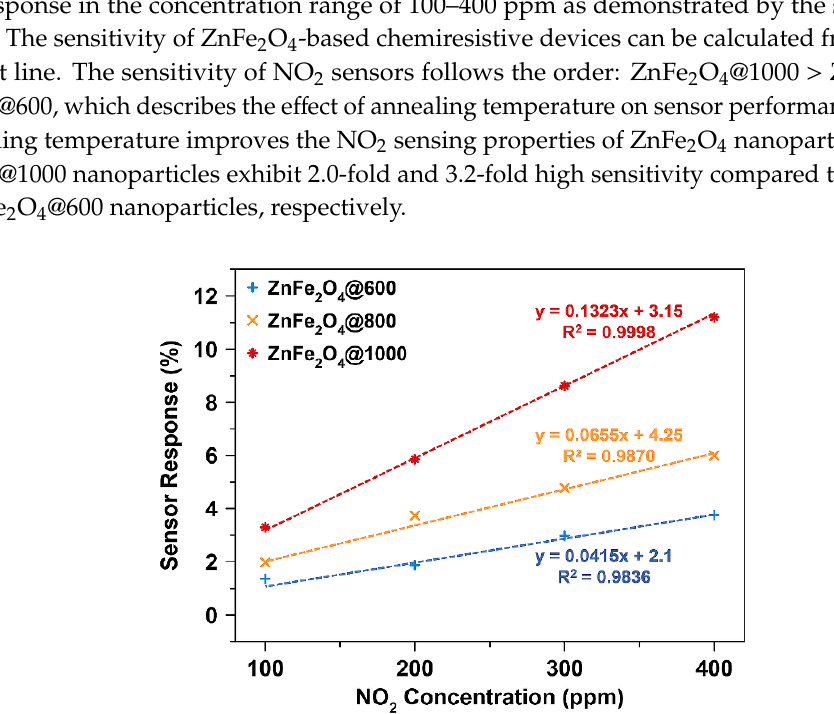
Figure 7. The calibration curves for different ZnFe 2 O 4 samples showing NO 2 sensitivity of the chemiresistive devices.